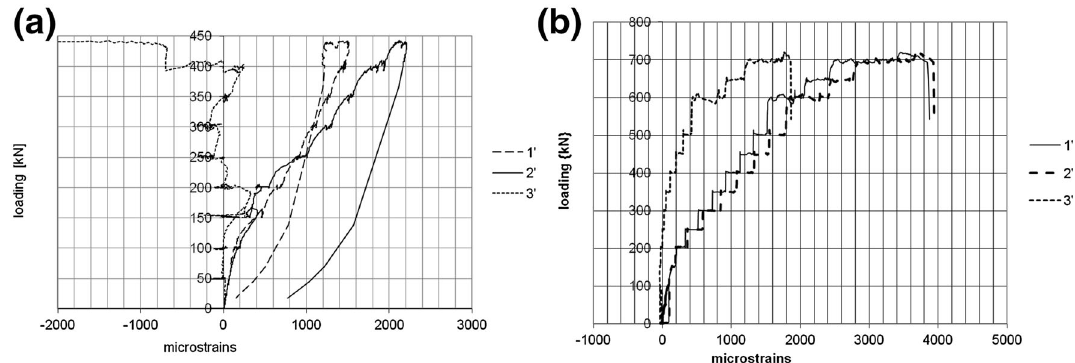
Fig. 19 Recorded strains in the reinforcement of the footings: a footing F6; b footing F9 (1 0 , 2 0 , 3 0 -measuring spots—Fig.